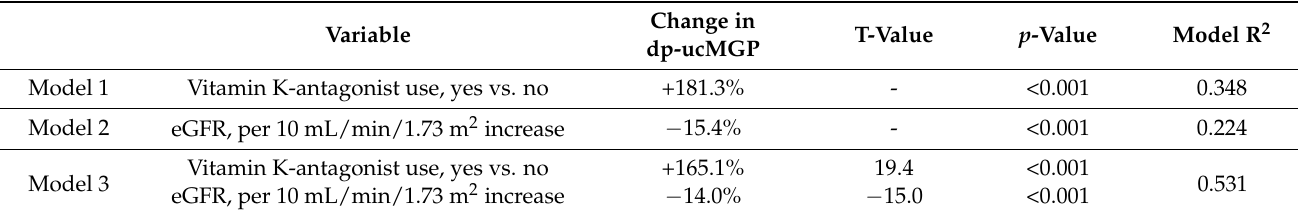
Table 2. Linear regression analyses with log 2 plasma dp-ucMGP concentration as dependent variable in 578 kidney transplant recipients from cohort 1.